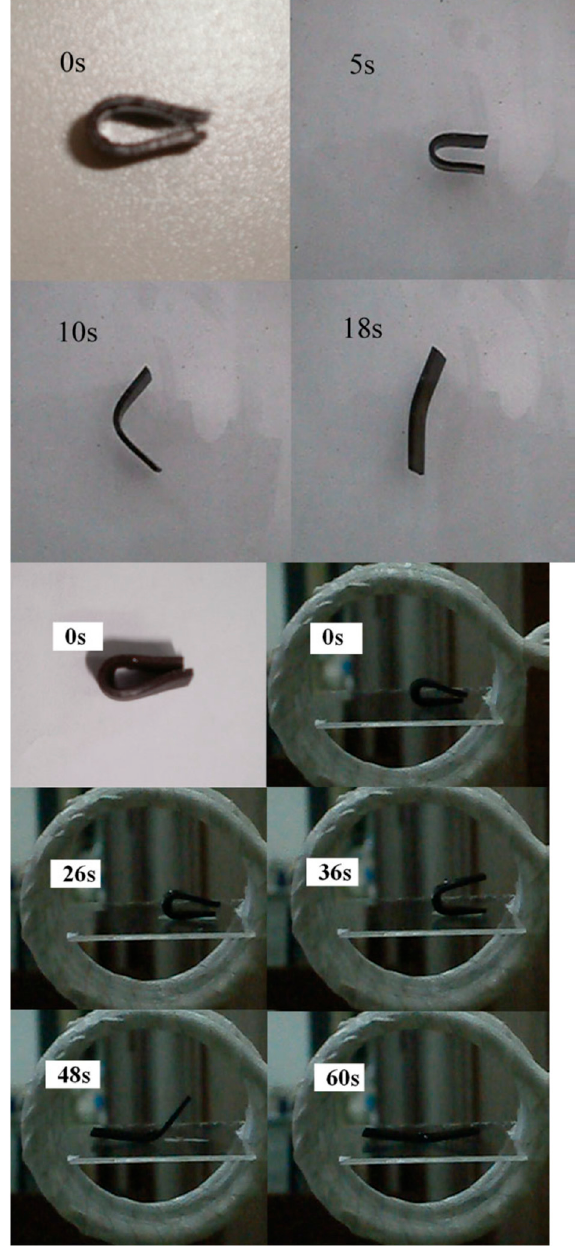
Figure 4. ( left ) The shape recovery process in hot water, ( right ) the shape recovery process in an alternating magnetic field [27] . alternating magnetic field